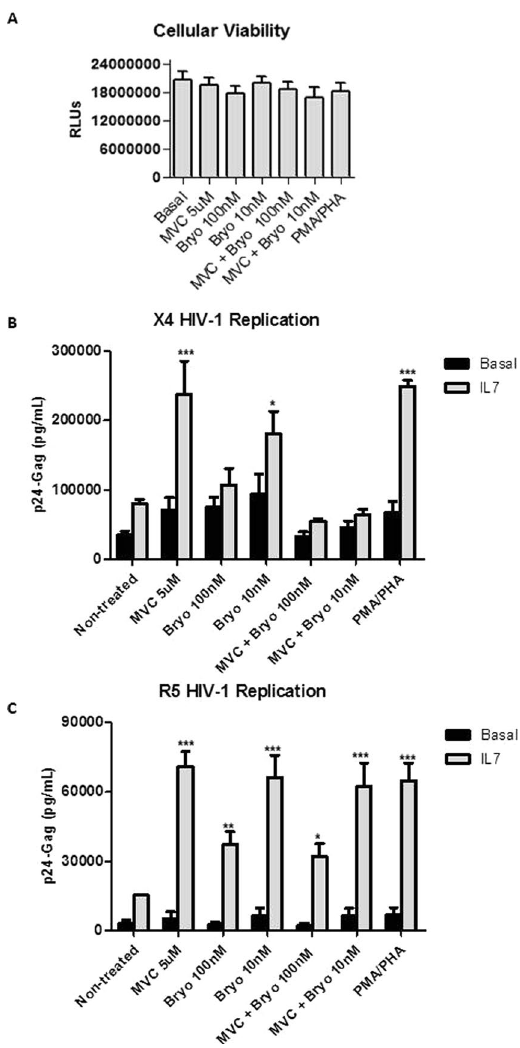
Figure 5. HIV-1 replication in TCM cells treated with MVC alone or in combination with Bryostatin-1. Primary TCM cells were treated with CCL19 or IL-7 for 5 days and then infected with X4-tropic NL4–3 strain or with R5-tropic BaL strain and cultured for 5 additional days. MVC (5 μ M) alone or in combination with Bryostatin-1 (100 nM or 10 nM) was added during the last 18 hr. Stimulation with PMA/PHA was used as positive control. ( A ) Cellular viability was measured. Cell viability was measured by chemiluminescence (RLUs) in CD4 + T cells treated with MVC, Bryostatin-1 or PMA/PHA during 18 hr. ( B ) X4 HIV-1 and ( C ) R5 HIV-1 replication was assessed by quantifying p24/Gag levels in the culture supernatant. Statistical significance was calculated using Kruskal-Wallis test with Dunn’s Multiple Comparison Test for ( A ) and two-way ANOVA with Bonferroni post-test analysis for ( B ) and ( C ) ( * p < 0.05 and *** p <